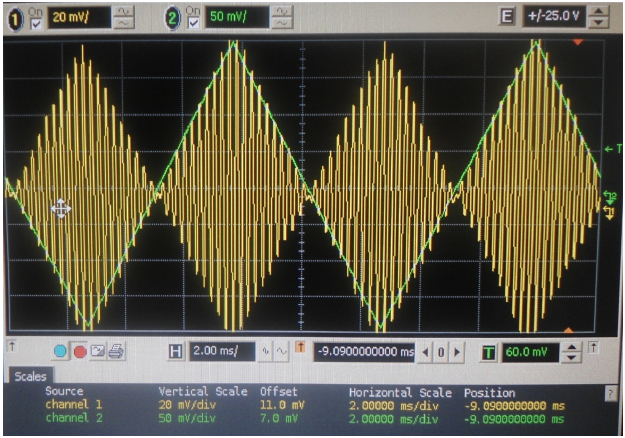
Figure 15. Experimental results of the analog multiplier.